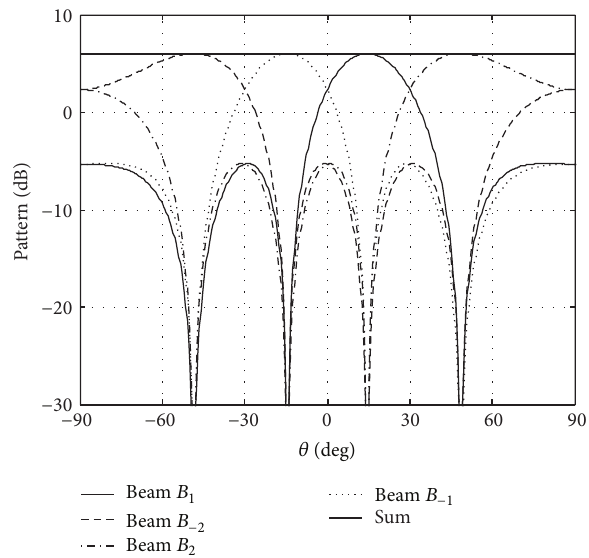
Figure 5: Radiation patterns of a 4 × 4 symmetrical Butler matrix.